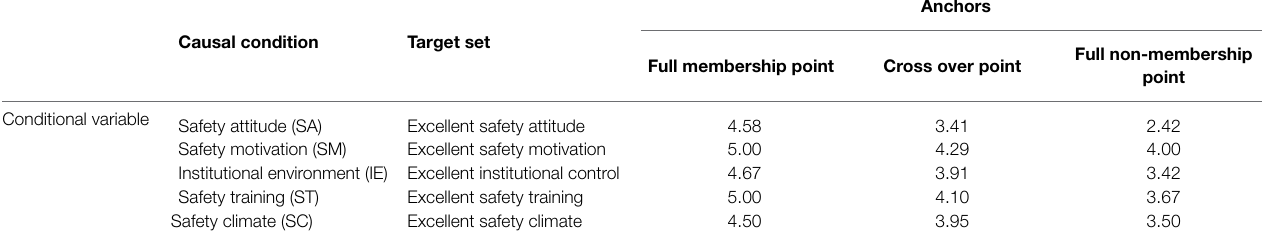
Causal condition Target set